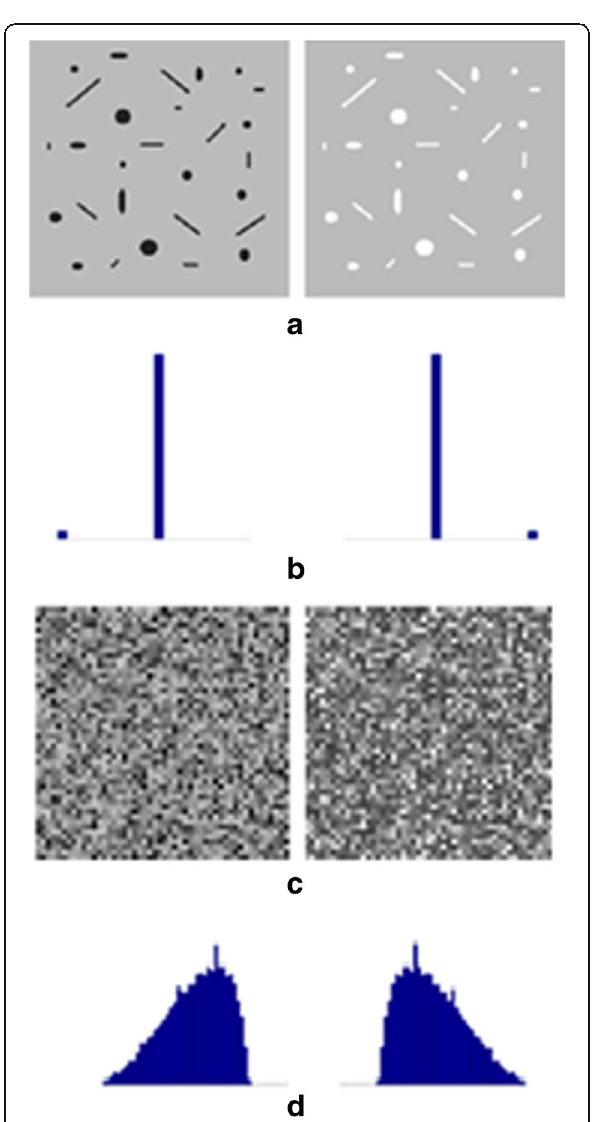
Fig. 2 a Example Image1 having similar patterns. b Histogram of images in a . c Example Image2 having similar patterns. d Histogram of images in